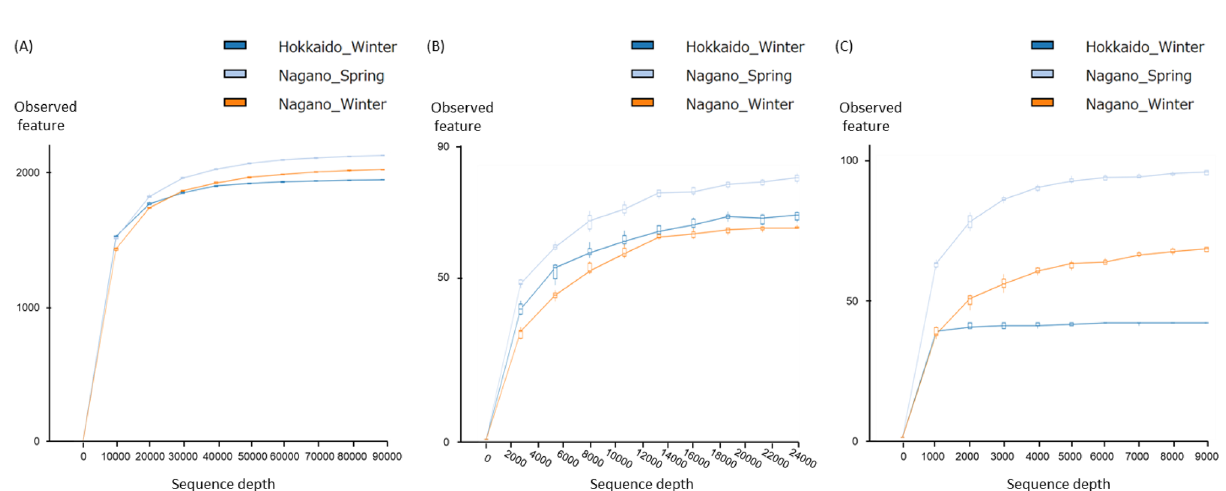
Figure 1. Alpha diversity of ruminal microbial and chloroplast composition in amplicon-seq analysis. Rarefaction curves of the observed OTUs are shown. ( A ) Bacterial taxa in the 16S rRNA dataset, ( B ) eukaryotic taxa without chloroplasts and host mitochondria in the 18S rRNA dataset, and ( C ) chloroplast taxa in the 18S rRNA dataset. Blue represents Hokkaido winter, pale blue represents Nagano spring, and orange represents Nagano